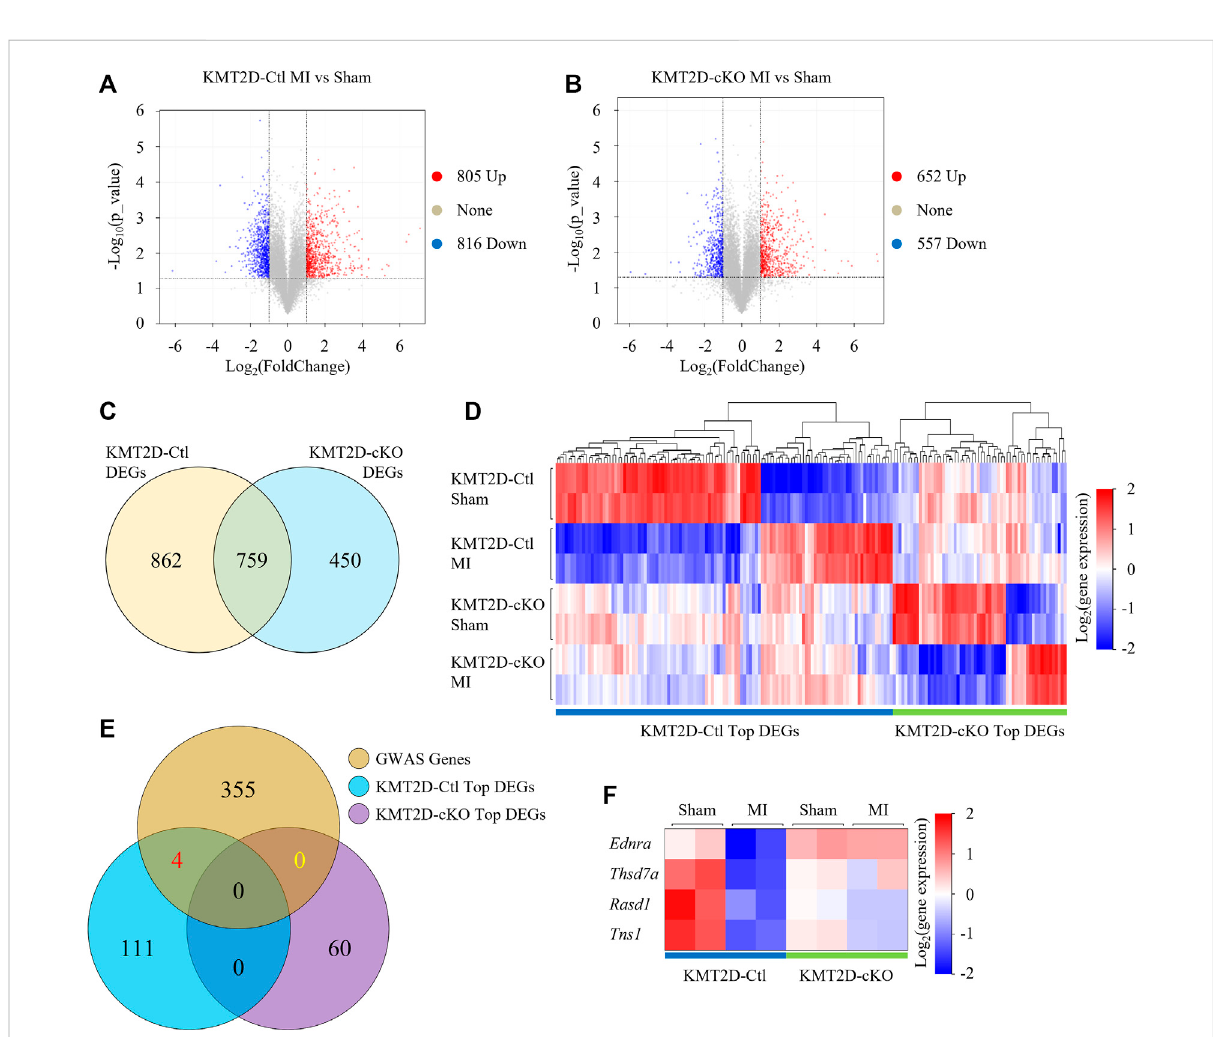
FIGURE 2 RNA-Seq analysis. (A,B) Volcano plot visualizes DEGs ( | log 2 ( FoldChange )| > 1, p < 0.05, FDR < 0.1) between MI and sham KO in the KMT2D-Ctl mice (A) andKMT2D-cKOmice (B) .Eachpointinthescatterplotrepresentsagene.Genesthatup-regulatedareshowninredanddown-regulatedin blue. Grey re fl ects genes whose expression levels are not signi fi cantly changed. (C) Venn diagram shows DEGs uniquely in KMT2D-Ctl mice hearts post-MI (862 genes), uniquely in the KMT2D-cKO mice hearts post-MI (450 genes), and in both (759 genes). (D) Heatmap is used to depict the top 115 DEGs after MI in the KMT2D-Ctl mice but no change in the KMT2D-cKO mice and the top 60 DEGs after MI in the KMT2D-cKO mice but no change in the KMT2D-Ctl mice. (E) Venn diagram displays the number of DEGs that associates with KMT2D during MI and genes from GWAS of human coronary artery disease. (F) Heatmap shows the transcription pro fi le of the four DEGs in all